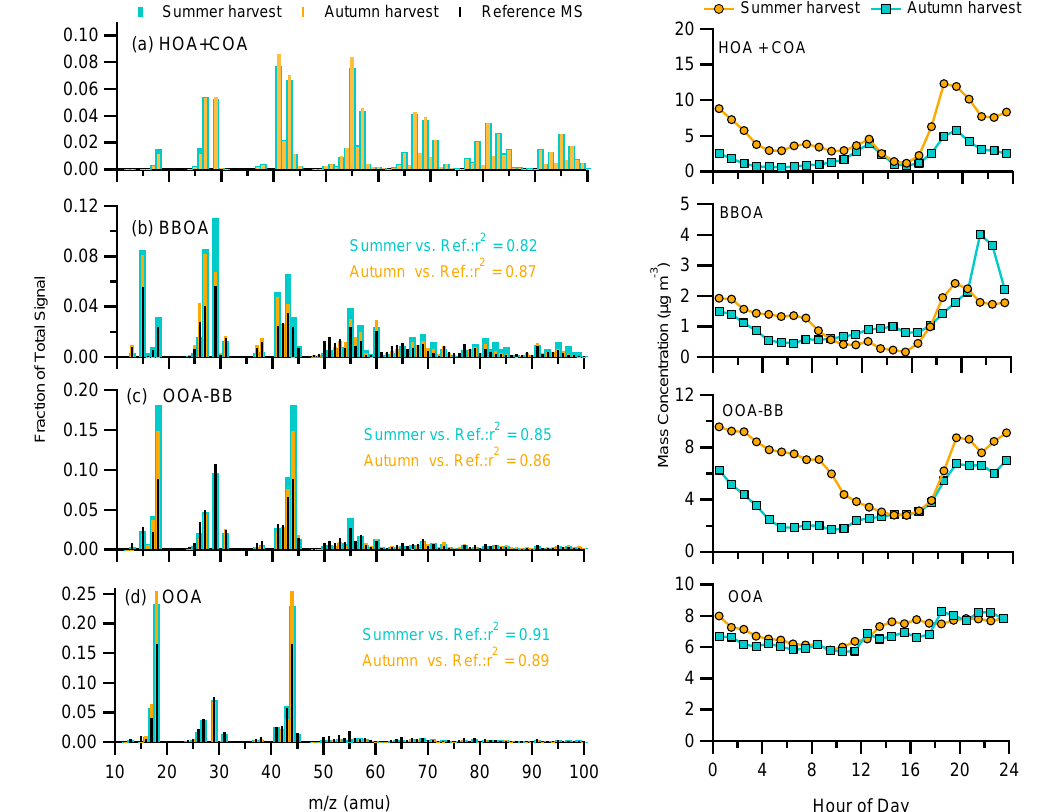
Figure 3. Mass spectra profiles (left) and diurnal variations (right) of four OA factors, i.e., hydrocarbon-like and cooking-emissions-related OA (HOA + COA), fresh biomass-burning (BB) OA (BBOA), oxygenated BB-influenced OA (OOA-BB), and highly oxygenated OA (OOA). Note that reference mass spectra (MS) are obtained from the results by Crippa et al. (2013), and oxygenated BBOA components have been resolved (OOA 2